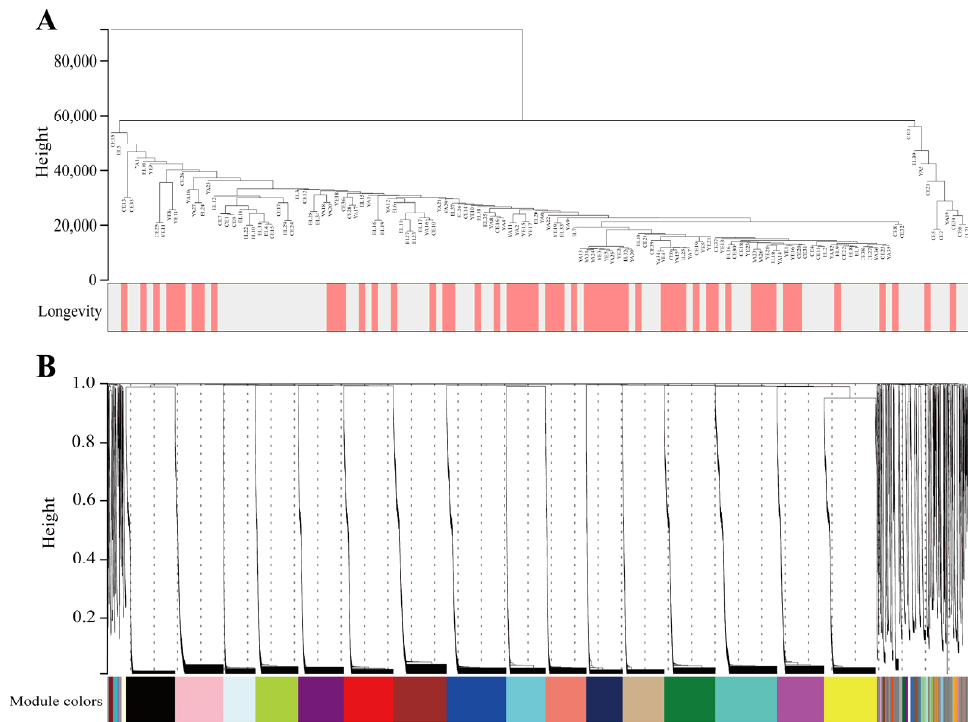
Figure 2. Construction of microecological co-expression modules. ( A ) Dendrograms and heatmaps of traits for 135 samples obtained from the longevity area. Colours indicate the proportion of traits, including longevity (age older 90 years) and sex. ( B ) Cluster dendrogram of OTUs. The branches above represent OTU clusters based on differences in topological overlap and the Colours of the assigned modules.